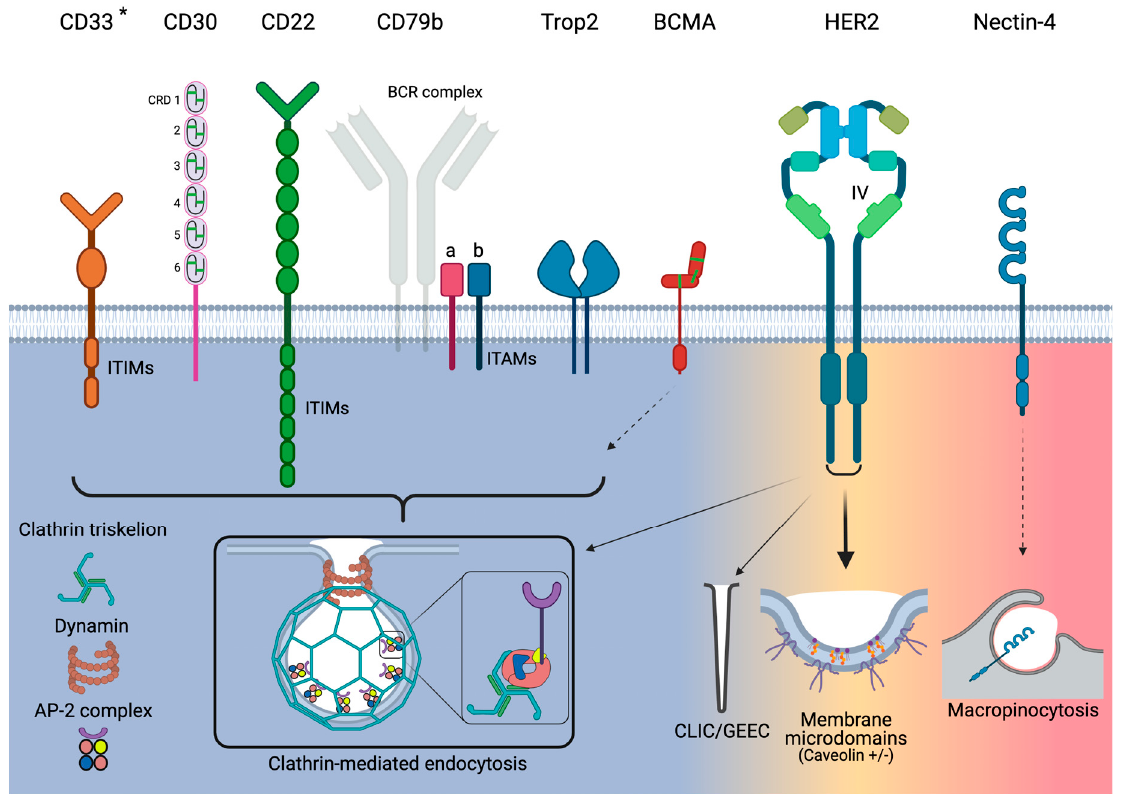
Figure 1. Overview of endocytosis pathways utilized by the target antigens for the currently approved ADCs. Narrow arrows indicate minor utilization by HER2. Dashed arrows indicate that only indirect evidence exists. * Although CD33 utilizes clathrin-mediated endocytosis, it acts independently of AP-2. Green bars for CD30 and BCMA represent disulfide bonds.